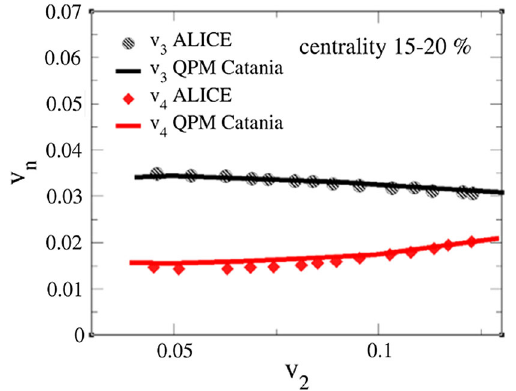
Fig. 4 Correlations between v n and v m ( n = 2 , m = 3 , 4) for charged √ s NN = 2 . 76 TeV for 15 − 20% particles in PbPb collisions at centrality class. The red and black points are experimental data taken from ALICE Collaboration [63]